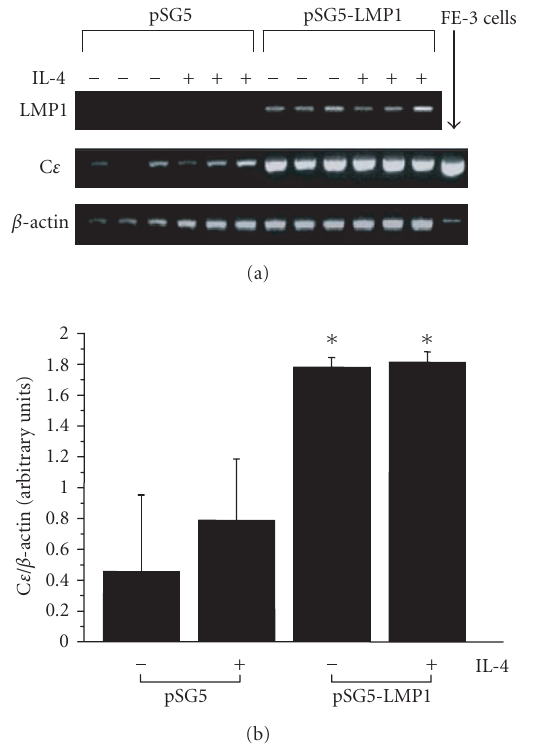
Figure 2: E ff ect of LMP1 expression on C ε mRNA levels of spleno- cytes derived from nonimmunized BN rats. The pSG5-LMP1 or empty vector pSG5 was transfected into the splenocytes derived from nonimmunized BN rats using lipofection method. (a) LMP1 and C ε mRNA expressions including both germline and mature C ε transcripts were determined by RT-PCR as described in the “materi- als and methods.” The results of three independent experiments are shown. (b) C ε mRNA levels are represented by the values normal- ized to the intensity of PCR products for β -actin. Data are expressed as means ± SD of six independent experiments. ∗ P < . 05 for with or without IL-4 treatment, pSG5-LMP1 versus pSG5.